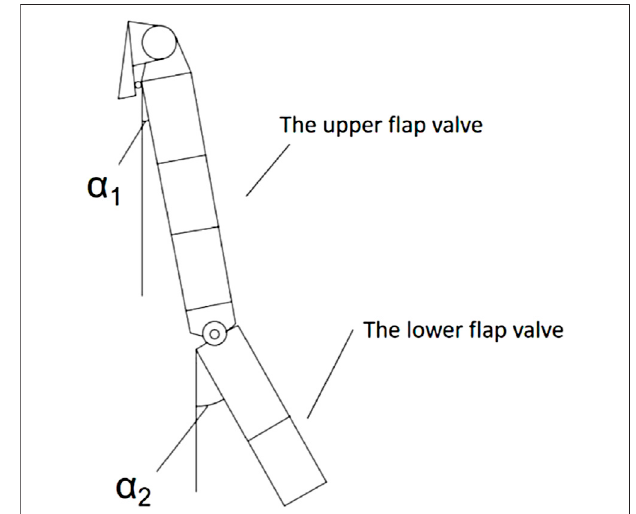
FIGURE 5 | Distribution of fl ap valve